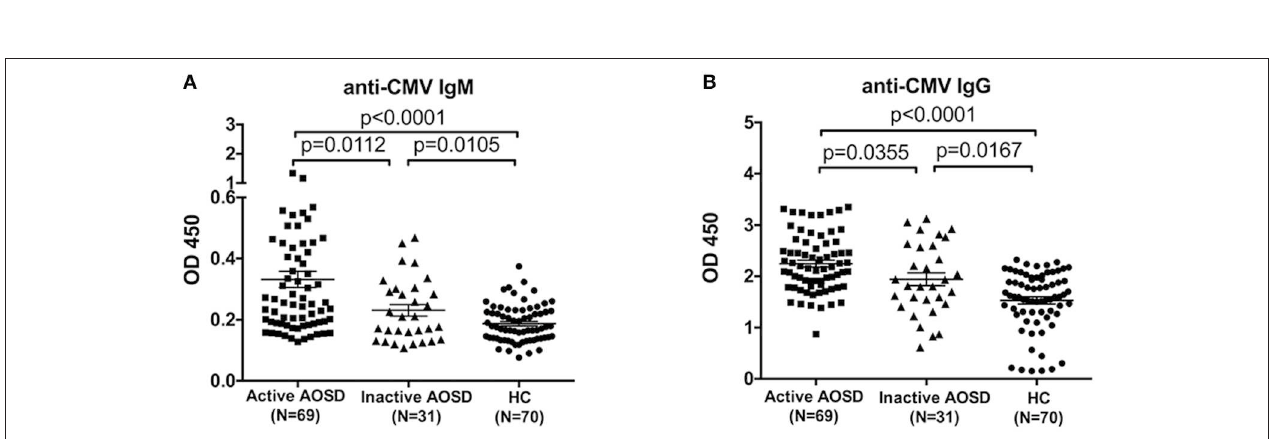
FIGURE 2 | Anti-CMV antibody levels in AOSD patients with diverse disease activity and HCs. (A) Plasma levels of anti-CMV IgM antibody in active AOSD ( N = 69), inactive AOSD ( N = 31) and HCs ( N = 70). (B) Plasma levels of anti-CMV IgG antibody in active AOSD, inactive AOSD and HCs. The data represent the mean ± SD by Student’s t